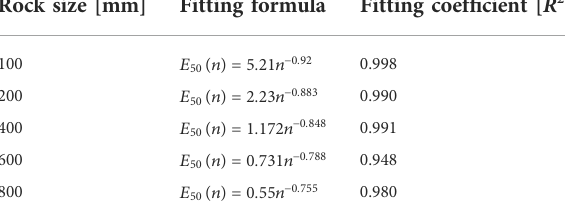
TABLE 4 Fitting relationship between the secant modulus and